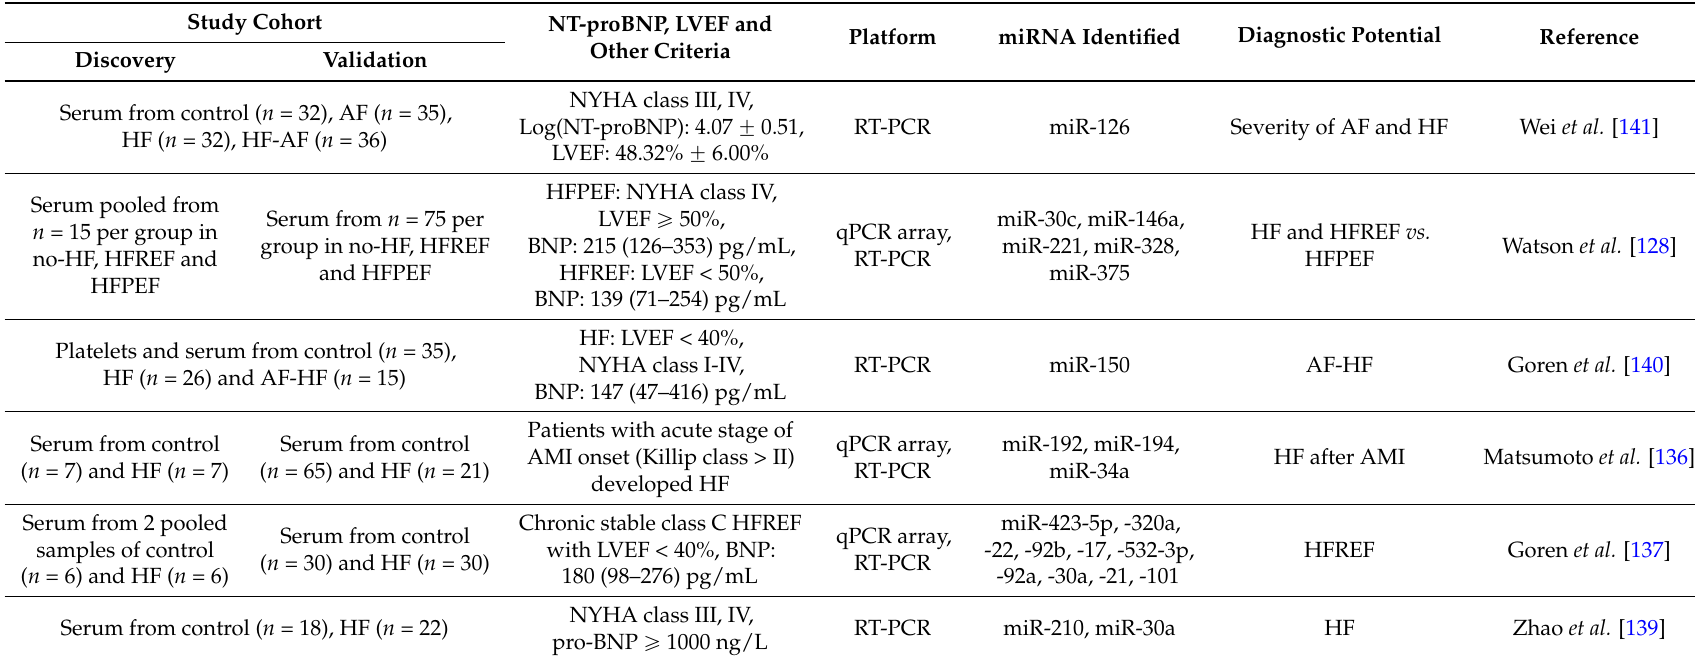
Table 5. Summary of reported miRNAs as HF biomarkers in serum